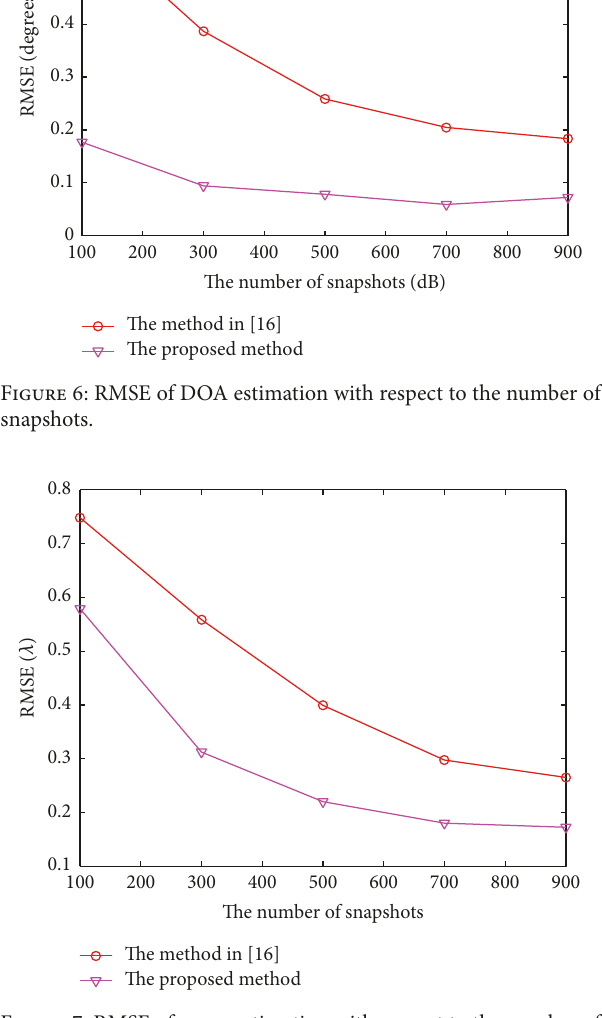
Figure 7: RMSE of range estimation with respect to the number of snapshots.